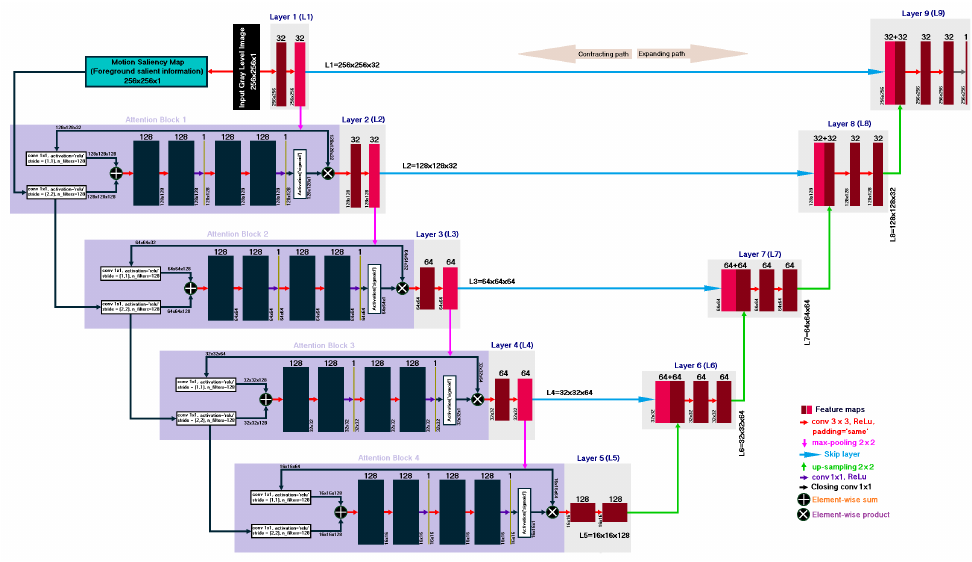
Figure 2. Our proposed